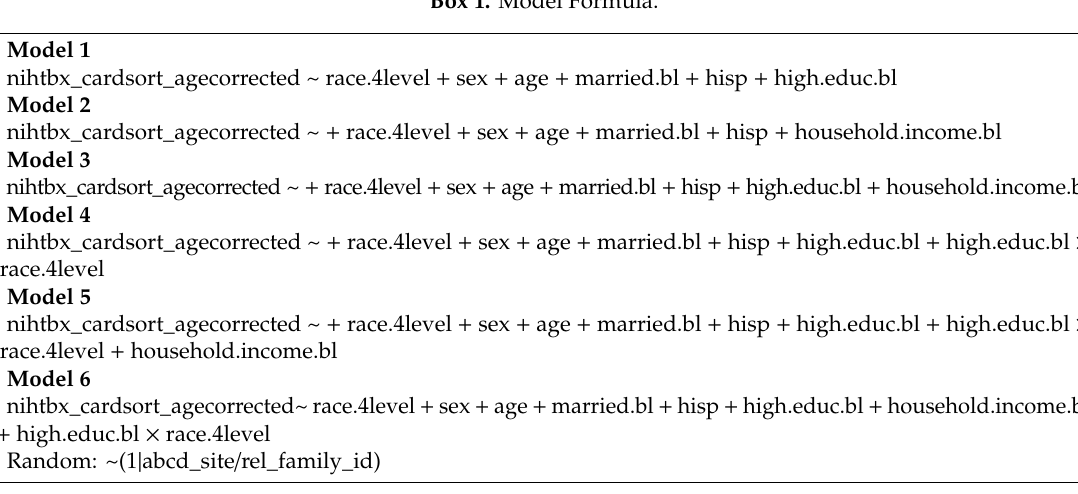
Figure 1. Testing our model’s assumptions: ( a ) distribution of our outcome, ( b ) residuals, and ( c ) quantiles. Box 1. Model